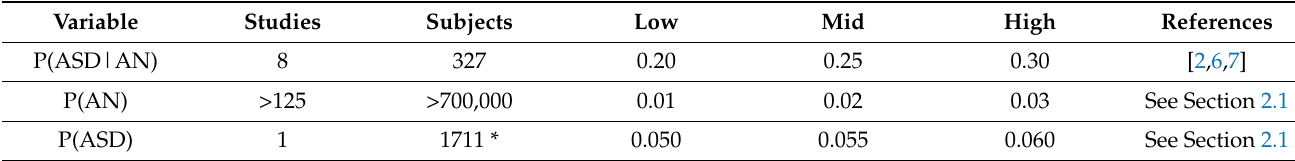
Table 2. Probability ranges for independent